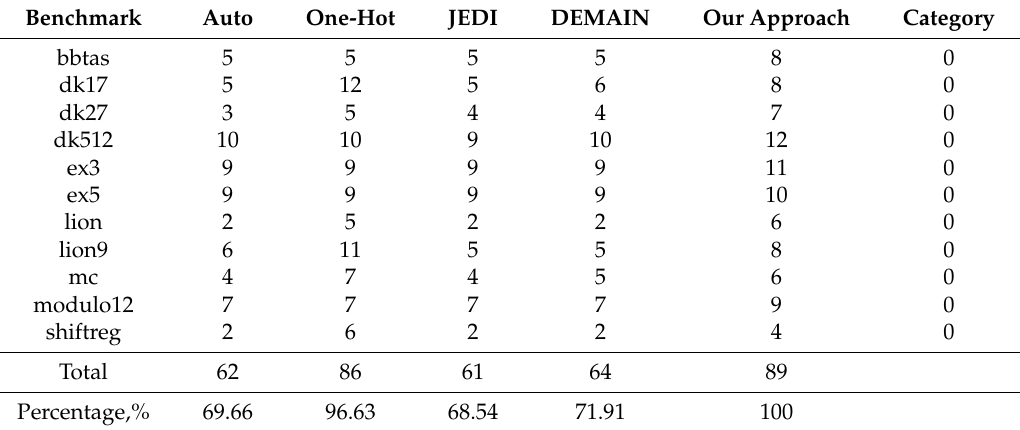
Table 7. Experimental results for category 0 (the number of